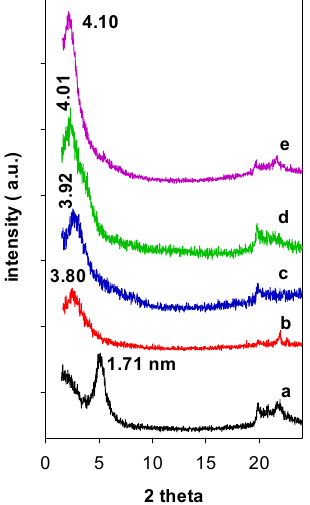
Figure 1. PXRD patterns of Zr intercalated clays (Zr(X) ‐ Mt) with different starting Zr/clay ratios. (a) 0, (b) 3, (c) 6, (d) 12, and (e) 24.